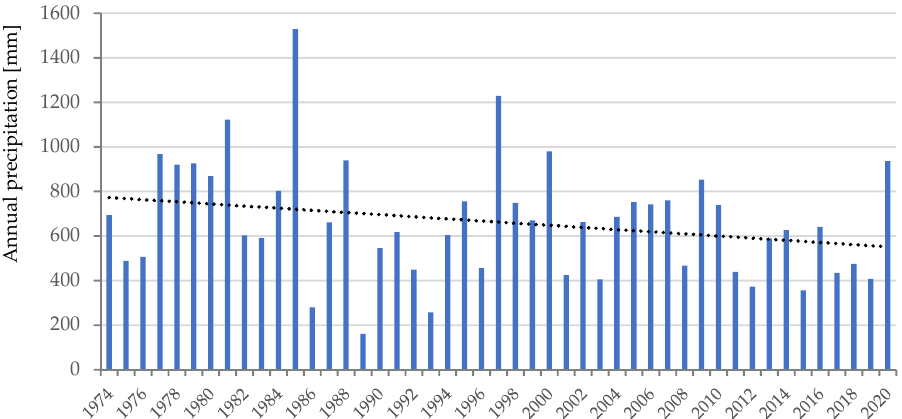
Figure 2. Precipitation (mm) data between 1974 and 2020 (Source: prepared by the authors based on data from ANA).